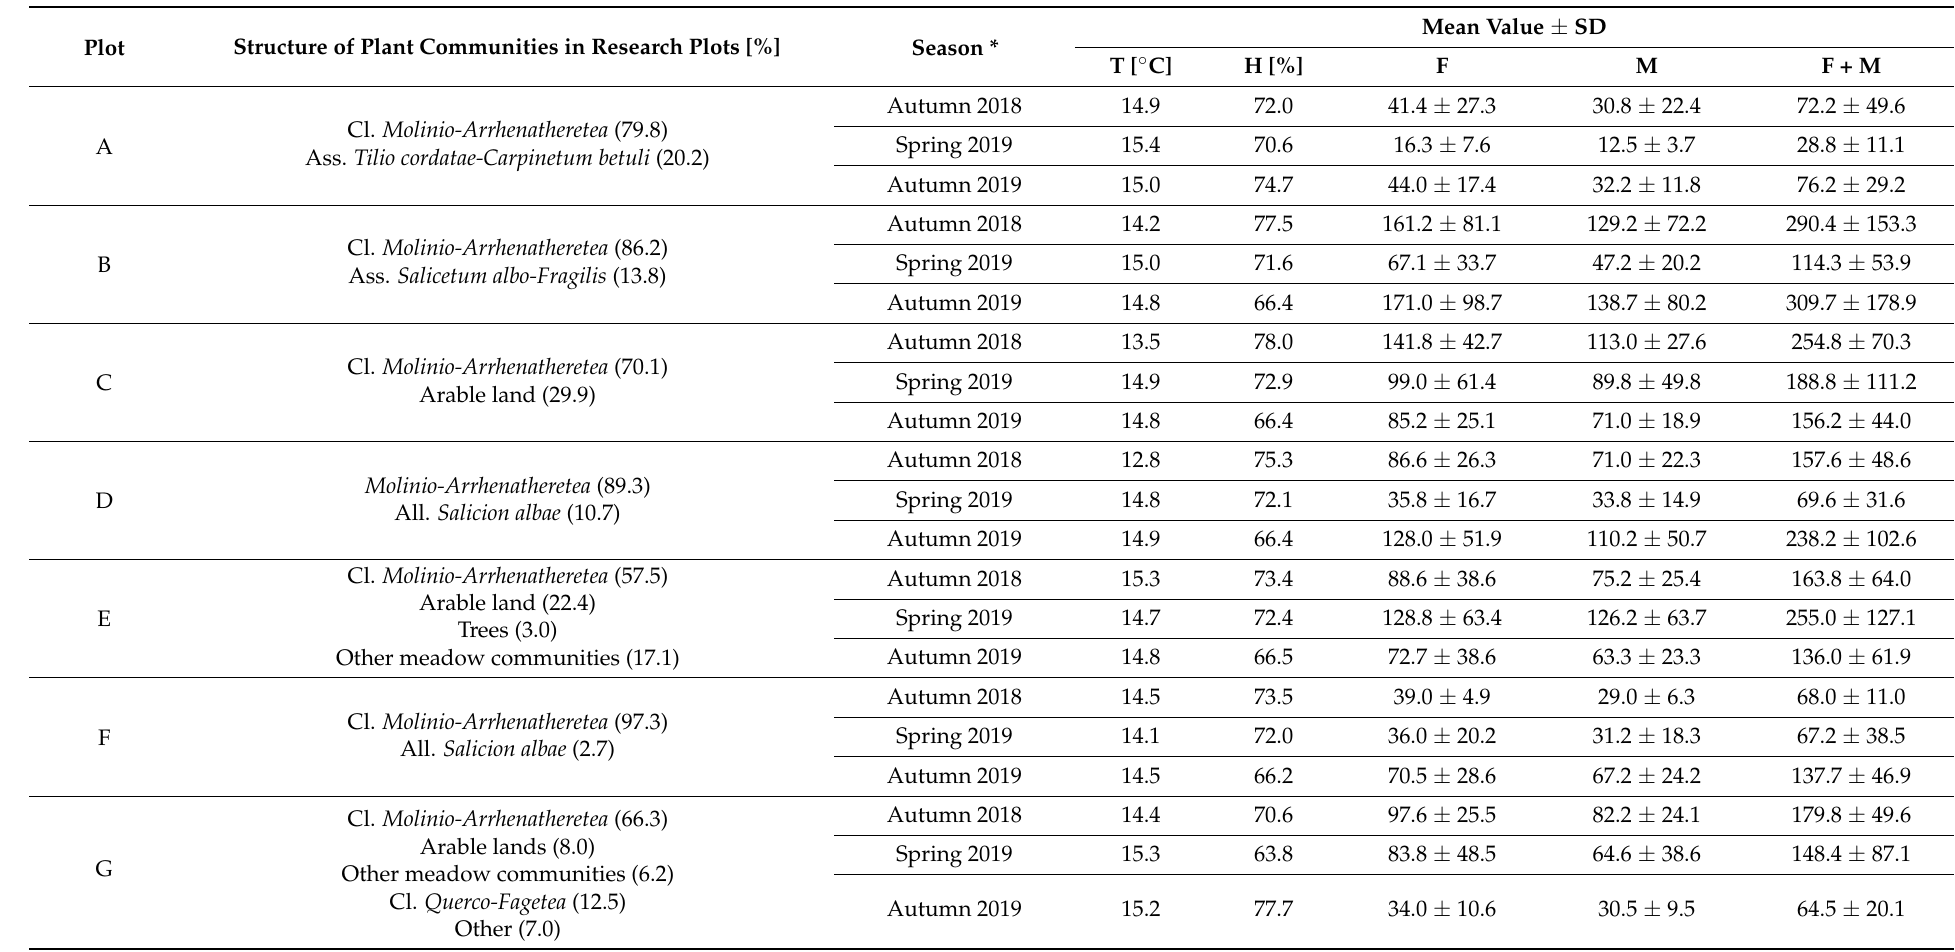
Table 2. Structure of plant communities in the research plots, average numbers of Dermacentor reticulatus adults collected in the research plots for 30 min, and mean values of air temperature and humidity prevailing at the time of tick collection. Plot Structure of Plant Communities in Research Plots